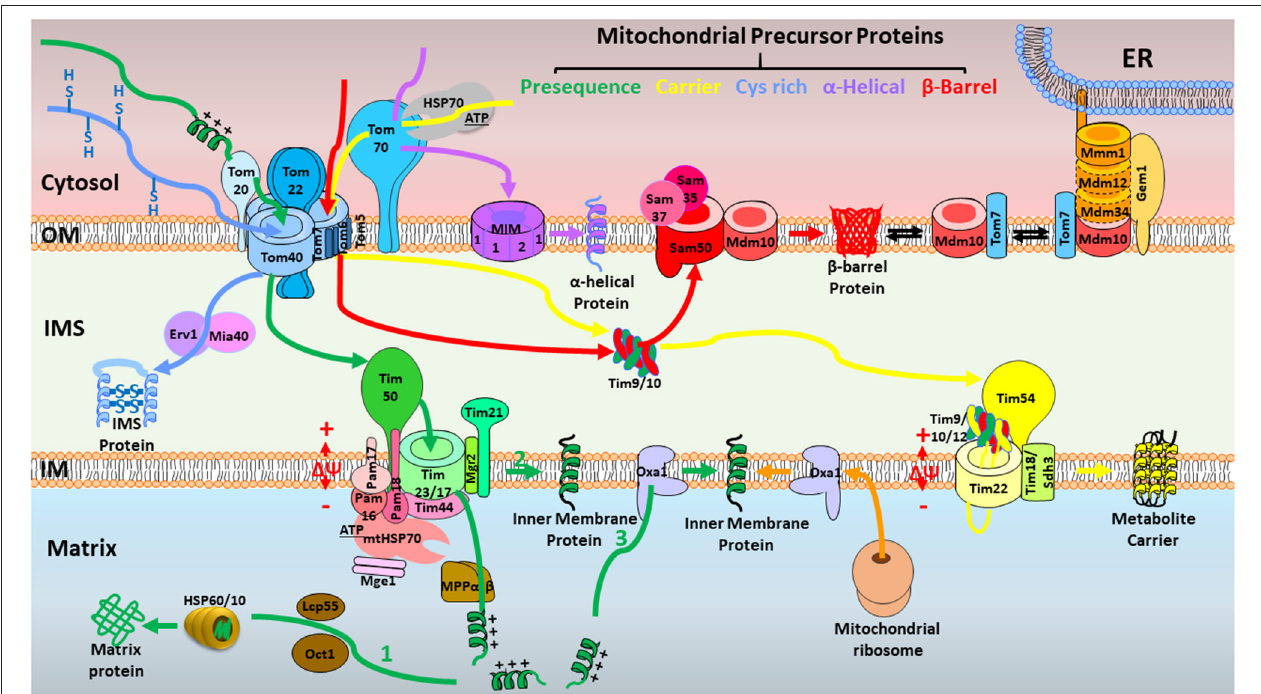
FIGURE 1 | Overview of the major mitochondrial protein import pathways in yeast. First, the presequence pathway transports presequence-carrying cleavable preproteins to the mitochondrial matrix (1) or IM (2, 3) (in green). Presequence-carrying precursors to the mitochondrial matrix (1) are typically recognized by TOM at the OM, passage the IM through TIM23, and are driven into the matrix assisted by PAM. 1 ψ across the IM is essential for the entry of presequences into the matrix. The presequences are cleaved by MPP, and additional proteolytic processing occurs by intermediate cleaving peptidases. Presequence-carrying precursors that integrate into IM follow two distinct routes. IM proteins are either directly laterally released from the TIM23 complex (2) or transported into the matrix first followed by further insertion into the IM with the help of Oxa1 (3). Oxa1 also is responsible for insertion of IM proteins synthesized on mitochondrial ribosomes. Second, in the carrier pathway for the import of precursor proteins without a cleavable presequence, yet with internal targeting signals into the IM (in yellow), carrier precursors are accompanied by cytosolic chaperones, delivered to the Tom70 receptor of the TOM complex, bound by small TIM chaperones in the IMS, and eventually integrated into the IM by the TIM22 complex in a 1 ψ -dependent manner. Third, in the MIA pathway for cysteine-rich proteins to the IMS (in blue), the precursors are kept in a reduced state in the cytosol, imported by the TOM complex, oxidized by the MIA machinery, and stay in an oxidized state in the IMS. Fourth, in the SAM complex for β -barrel proteins to the OM (in red), the precursors of β -barrel proteins are imported by the TOM complex at the OM, bound to small TIM chaperones in the IMS, and inserted into the OM by the SAM complex. Fifth, some proteins with α -helical transmembrane segments are inserted into the OM by the MIM complex (in purple). Typically, the Tom40 channel is not involved in this route, but Tom70 is indispensable. In addition, ERMES is a complex that connects ER and mitochondrial OM, facilitating the dynamic substrate exchange between ER and mitochondrion. Mdm10 is a protein with dual localization in SAM and ERMES. OM, outer membrane; IM, inner membrane; IMS, intermembrane space; TOM, the translocase of the outer membrane; TIM23, the inner membrane translocase TIM23; PAM, presequence translocase-associated motor; 1 ψ , membrane potential; MPP, mitochondrial processing peptidase; Oxa1, oxidase assembly protein 1; TIM22, the carrier translocase of the inner membrane TIM22; MIA, mitochondrial intermembrane space import and assembly machinery; SAM, sorting and assembly machinery; MIM, mitochondrial import complex; ERMES, endoplasmic reticulum (ER)–mitochondria encounter